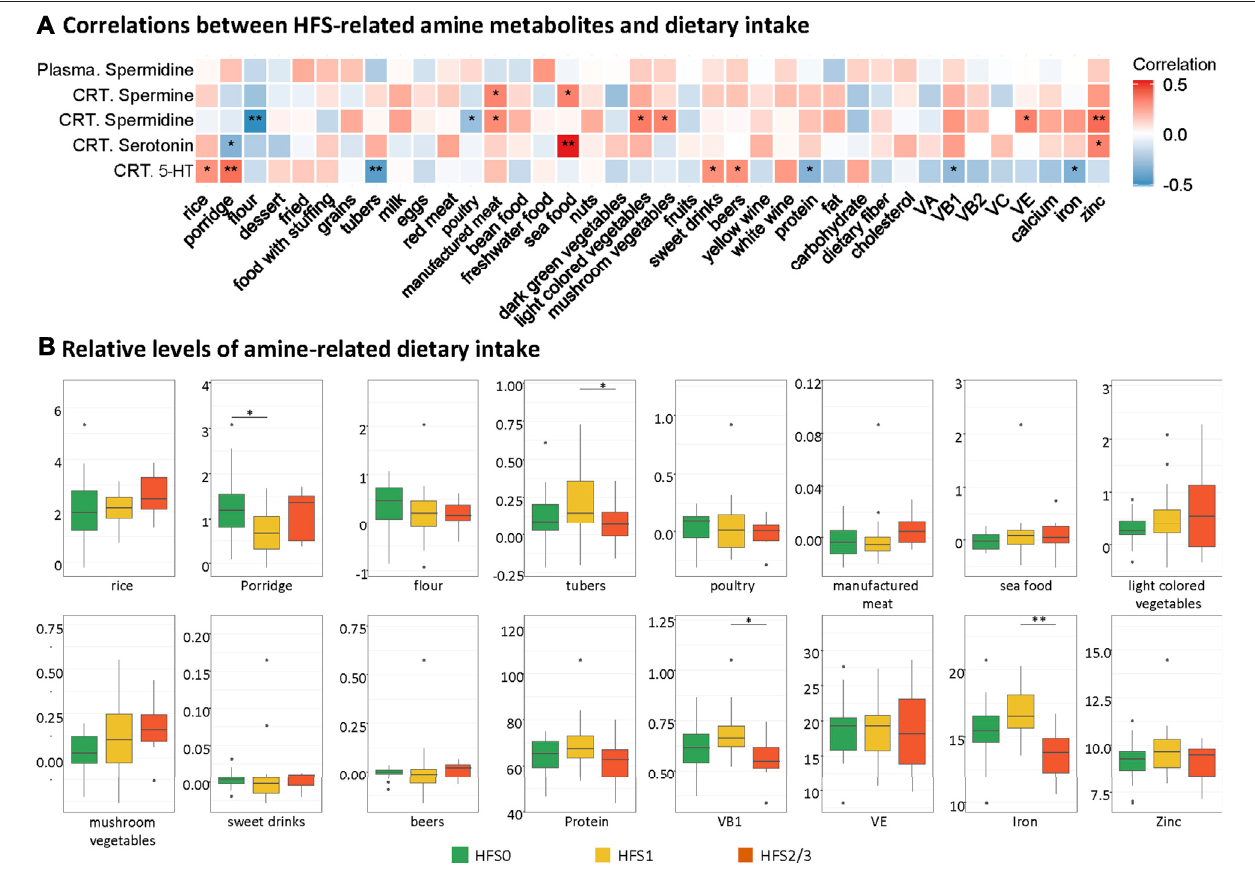
FIGURE 5 | Contribution of dietary intake to the levels of HFS-related amines in CRT. (A) Heatmap showing the correlations between HFS-related amine metabolites and dietary intake. Statistical signi fi cance was set as: * p < 0.05, ** p < − 0.01 (Spearman correlation). Red boxes represent positive correlations, and blue boxes represent negative correlations. (B) Boxplots show the relative levels of amine-related dietary intake. The Student ’ s t-test was used to examine the relationship between dietary intake for groups HFS0, HFS1, and HFS2/3, and signi fi cance was set as: * p < 0.05, ** p < − 0.01.